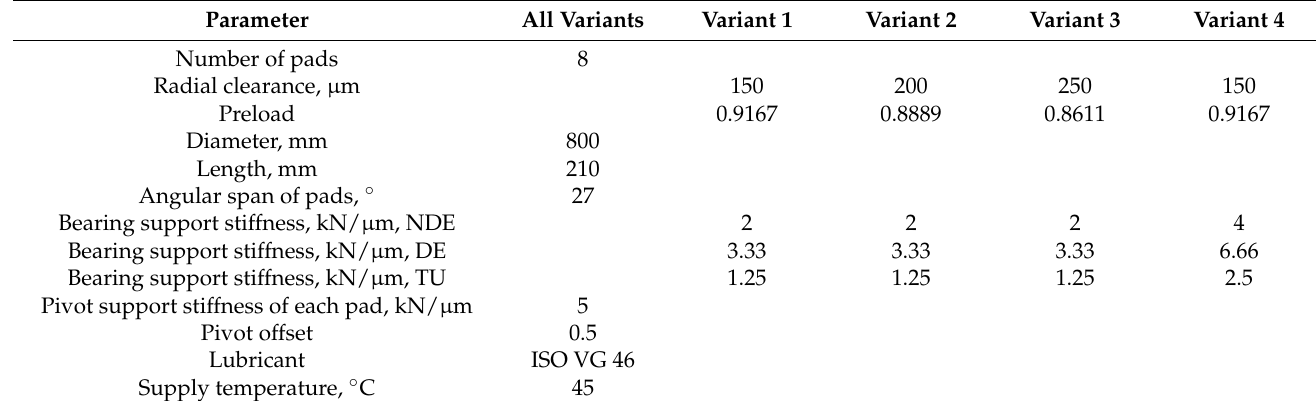
Table 3. Bearing design